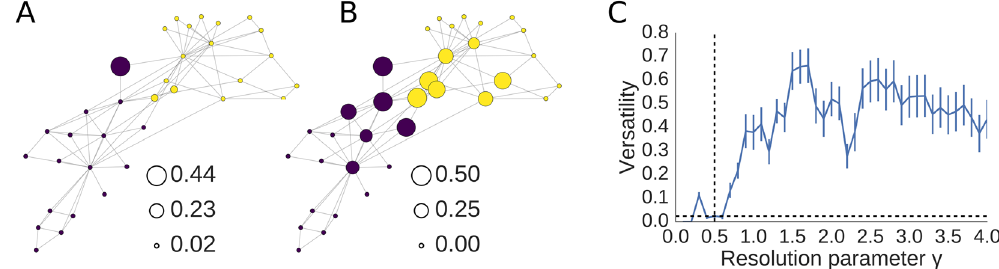
Figure 3. Versatility in the karate club network. ( A ) The versatility in Zachary’s karate club network is compared to ( B ) the participation coefficient in the same network, where the size of the node represents the versatility or the participation coefficient, respectively. Versatility is only high for the nodes in between communities, whereas participation coefficient is also high for the hubs since they tend to have more edges into the other community. The node with very high versatility has exactly one edge in each community. Nodes are coloured according to their community with a resolution parameter of 0.5, which is shown in ( C ) to minimise the mean versatility, i.e. providing the most stable communities. Participation coefficient in ( B ) was also calculated according to this partition structure. We know a priori that this club split from one group into two factions, and indeed this range of resolution parameter gives two communities. Error bars represent